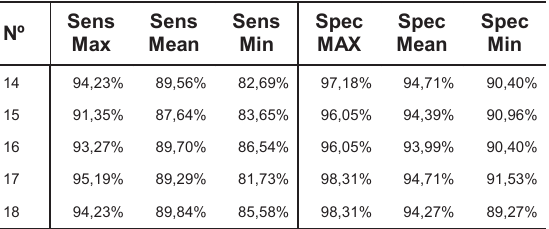
Table 1. Results of number of neurons in hidden layer